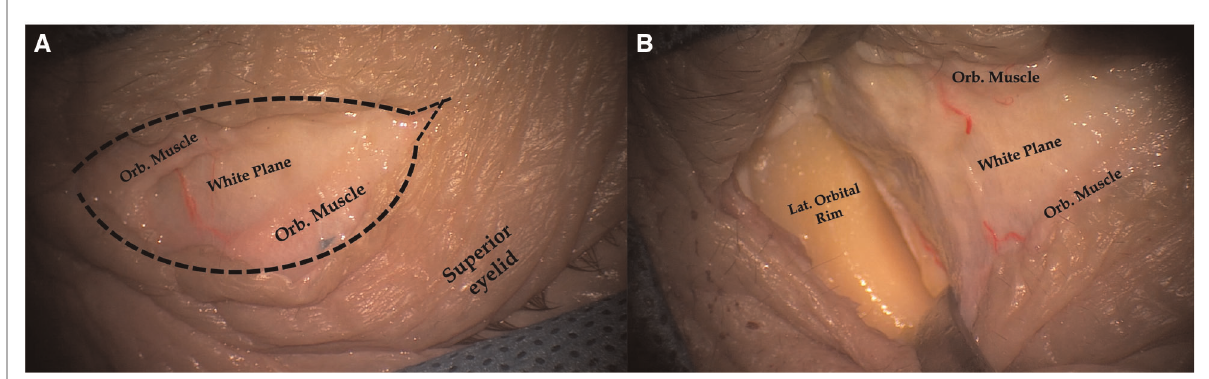
FIGURE 1 Pictures showing a skin incision for the endoscopic transorbital approach. The skin incision is run along a wrinkle of the superior eyelid. The orbicularis muscle is identi fi ed, and its fi bers are separated, thus exposing the “ white plane ” , which is formed by the orbital septum and superior tarsus and which represents the posterior limit of the dissection ( A ). Dissection proceeds laterally until the periosteum of the lateral orbital rim is reached and cut. After the lateral orbital rim is completely skeletonized, subperiosteal – subperiorbital dissection can be started ( B ). Black dotted line, skin incision; Orb. Muscle, orbitalis muscle; Lat. Orbital Rim, lateral orbital